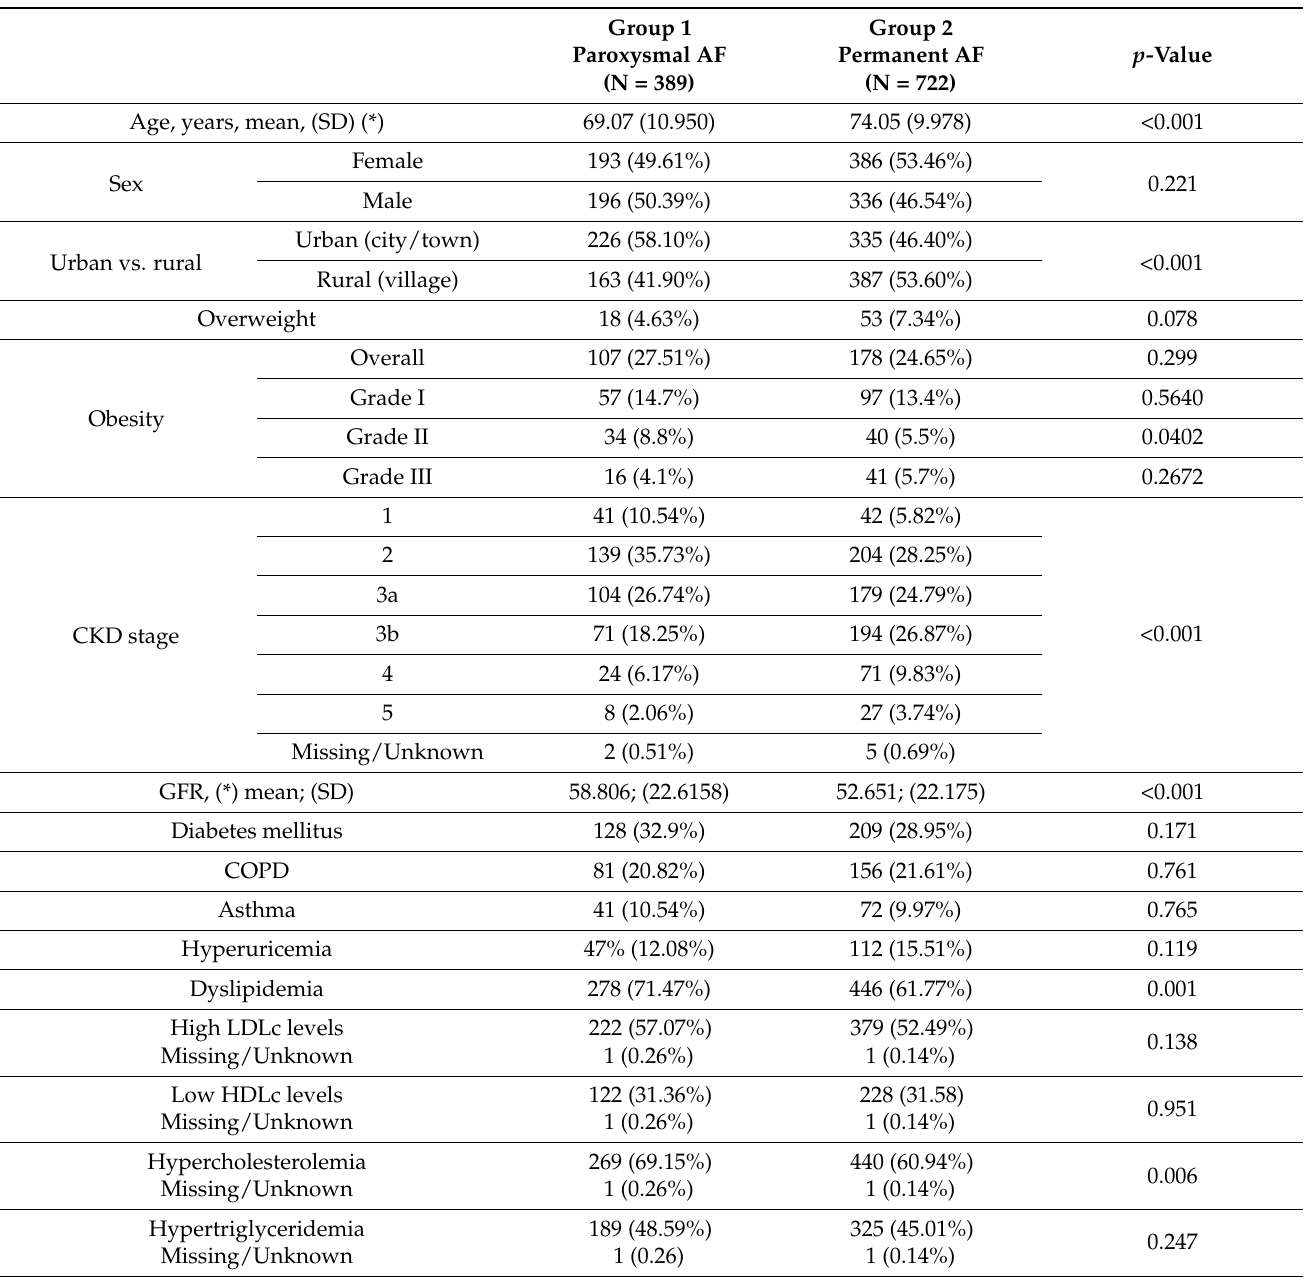
Table 1. Demographic and clinical characteristics (without cardiovascular comorbidities) of study groups. (AF—atrial fibrillation, COPD—chronic obstructive pulmonary disease, CKD—chronic kidney disease, GFR—glomerular filtration rate, HDLc—high-density lipoprotein cholesterol, LDLc— low-density lipoprotein cholesterol, Q1—25 percentage quartiles, Q3—75 percentage quartiles, SD— standard deviation, (*)—continuous